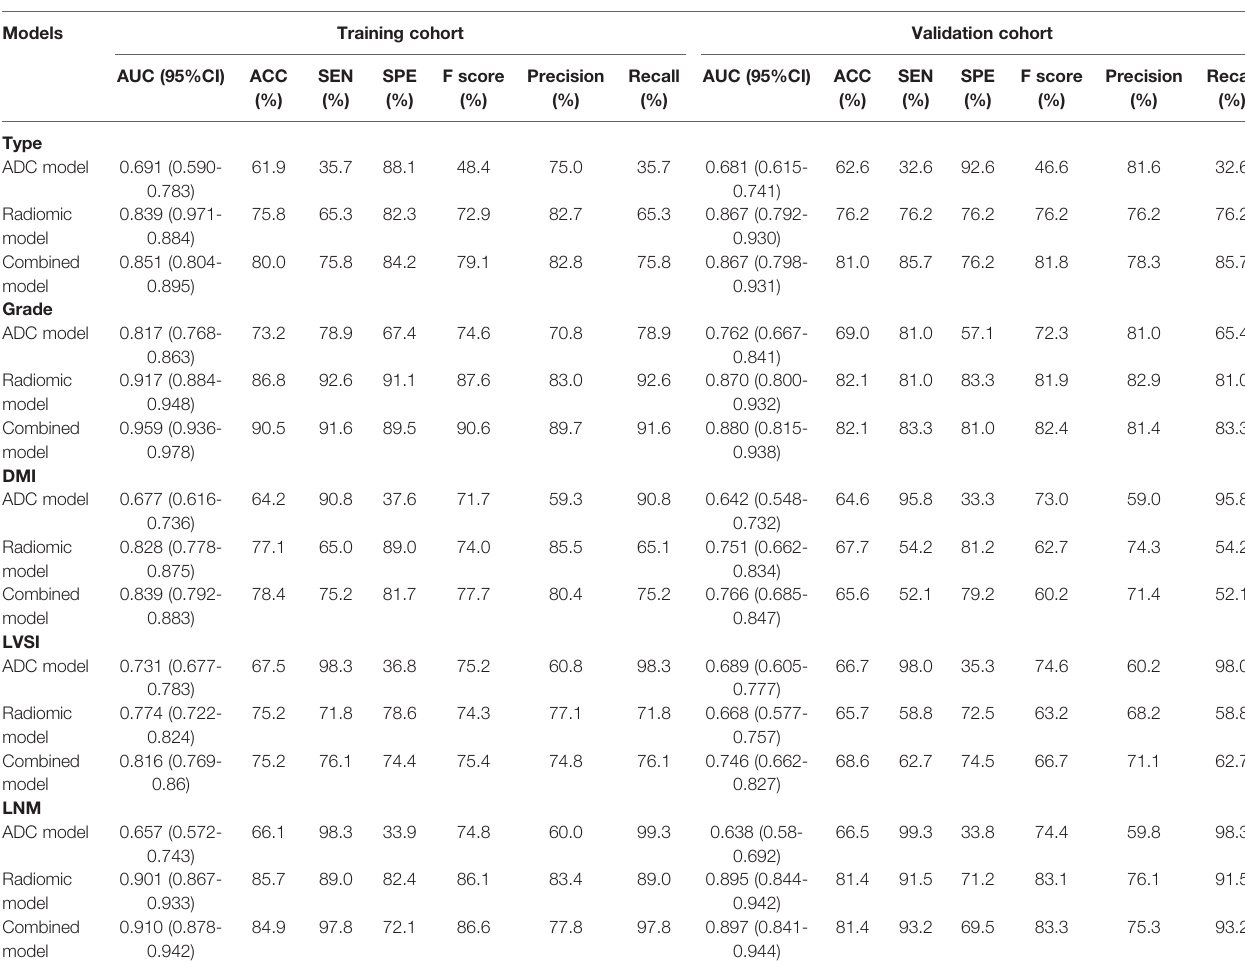
TABLE 3 | The predictive performance of the models in each